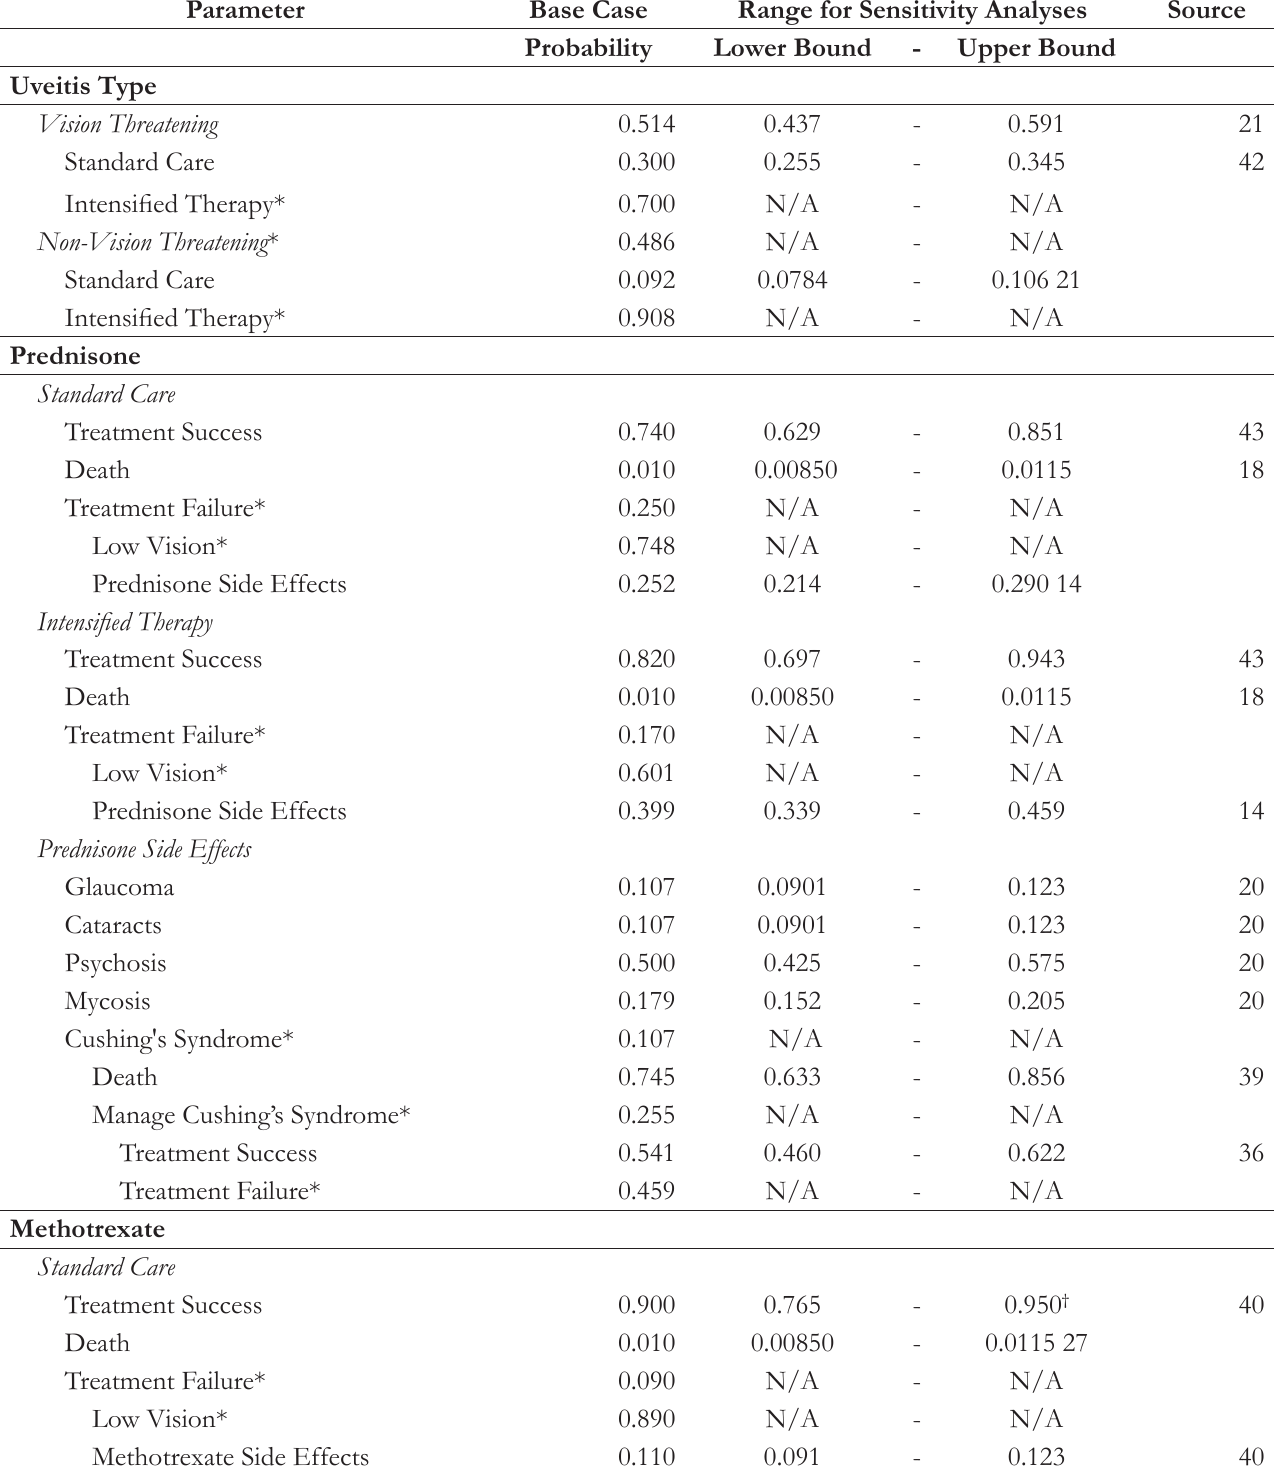
Table 1b. Probabilities and Transition Probabilities Parameter Base Case Range for Sensitivity